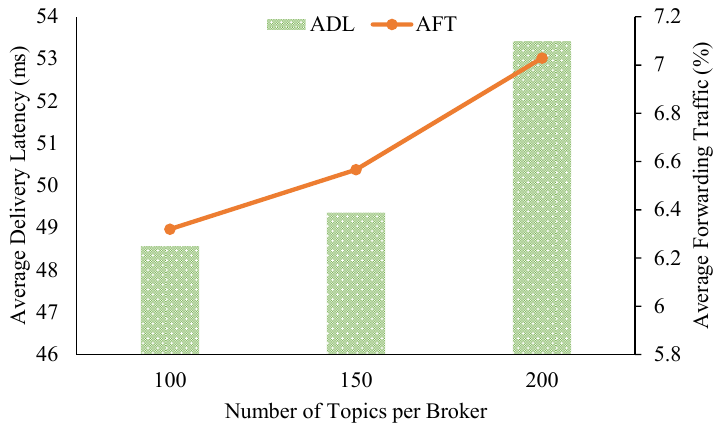
Figure 5. Data delivery latency and relay traffic from varying the number of topic subscriptions.